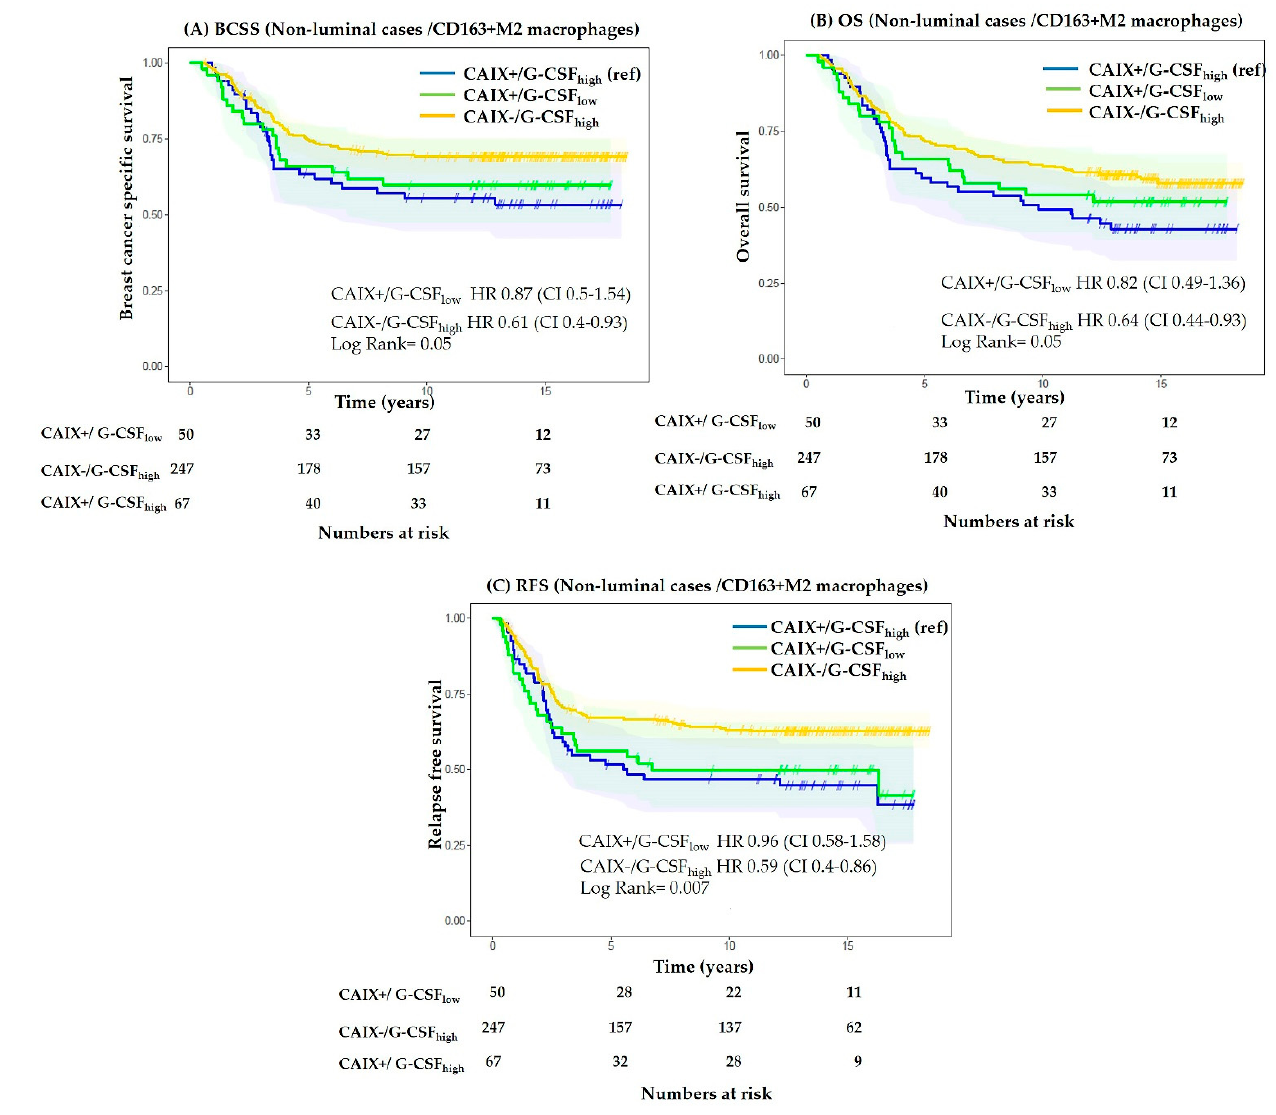
Figure 5. Kaplan–Meier curves for association of CAIX and G-CSF in CD163+ non-luminal cases. Breast cancer-specific sur- vival ( A ), overall survival ( B ), relapse-free survival ( C ). CAIX negative /G-CSF high phenotype is associated with significantly better relapse-free survival compared to CAIX positive /G-CSF low phenotype ( C ).